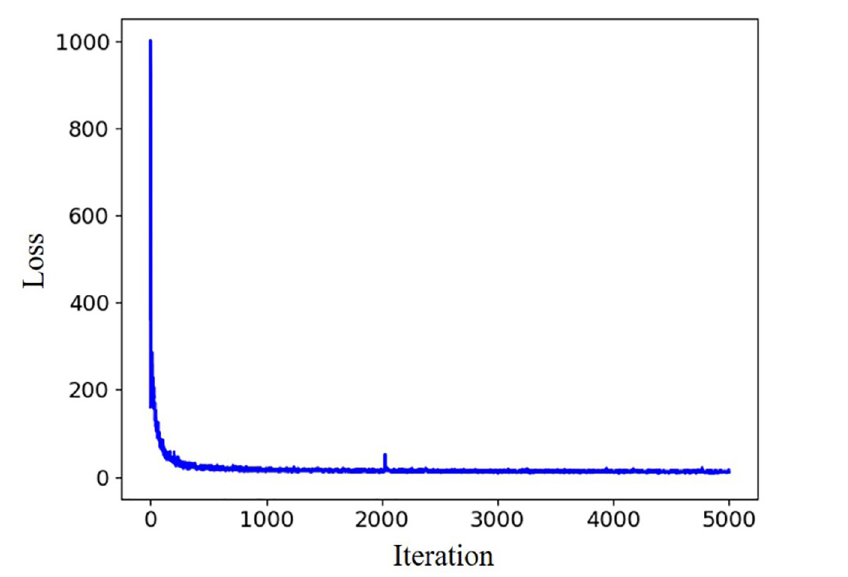
Fig 11. Training